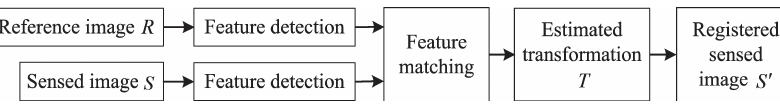
Figure 1. Flow chart of sparse